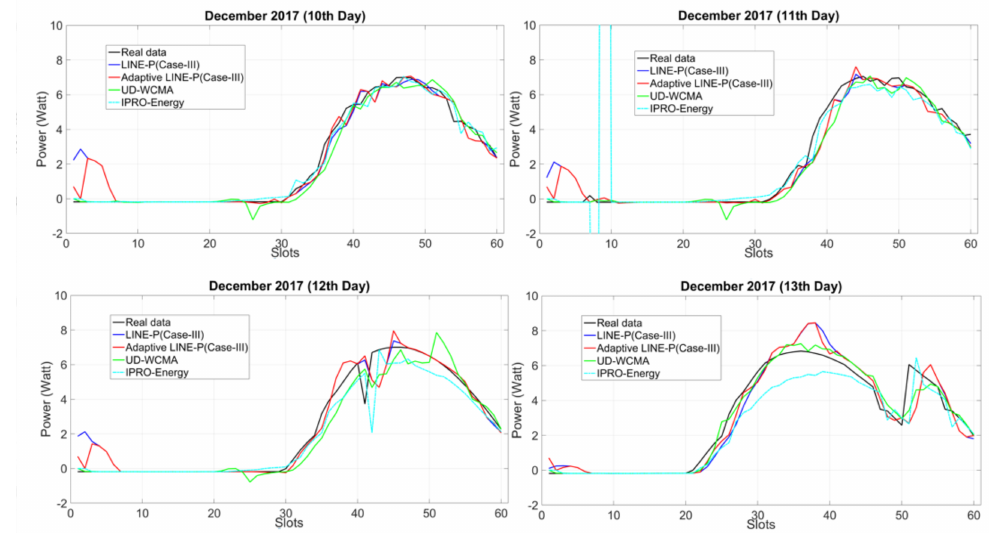
Figure 3. Graphical representation of Adaptive LINE-P (Case III) and state of the art based on the medium (22-min data interval) time period horizon of the solar profile with 61 time slots in 24 h.